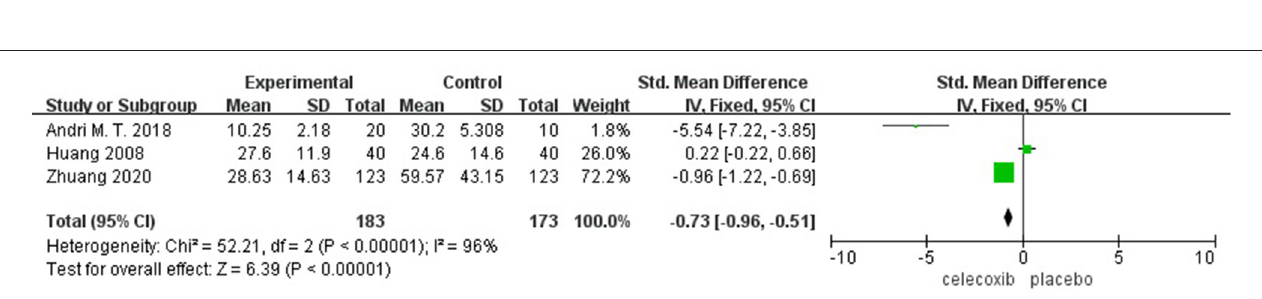
FIGURE 4 | Meta-analysis of morphine consumption over postoperative